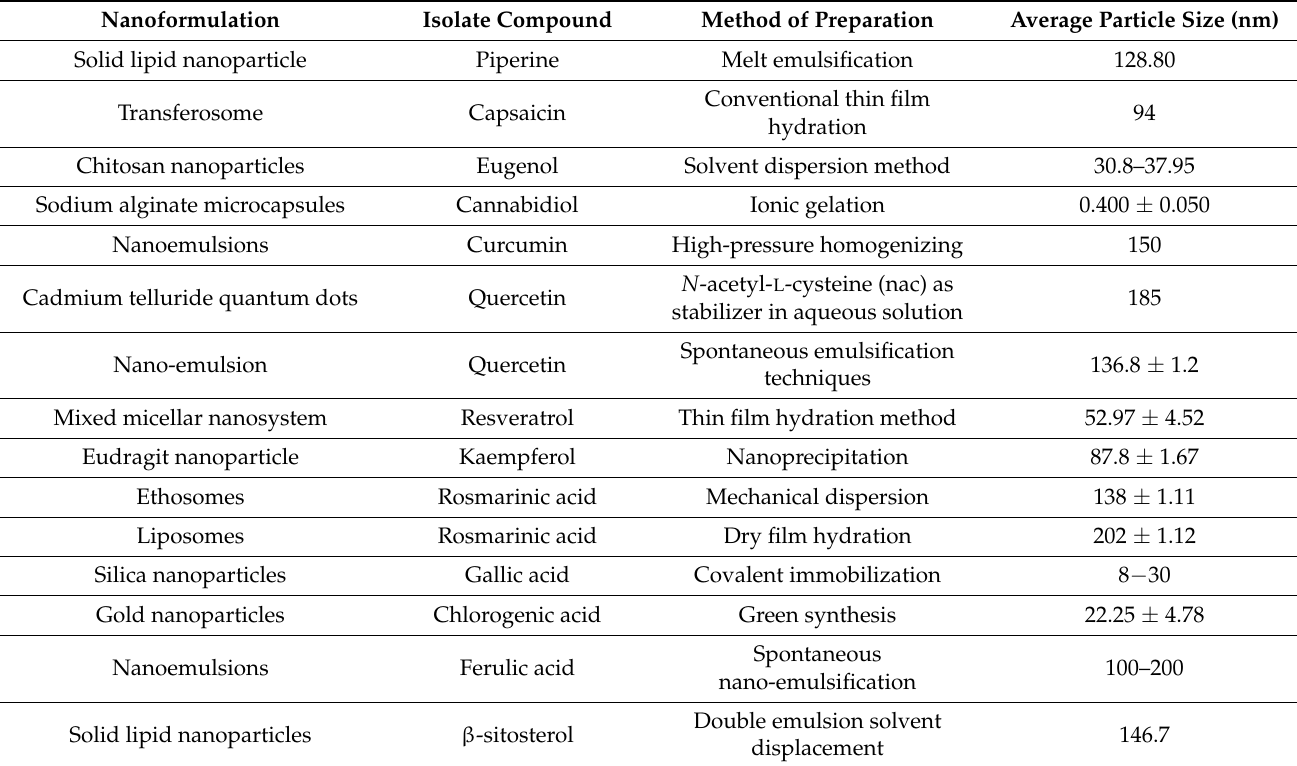
Table 2. Plant isolates with their nano-formulation for antiarthritic or antioxidant